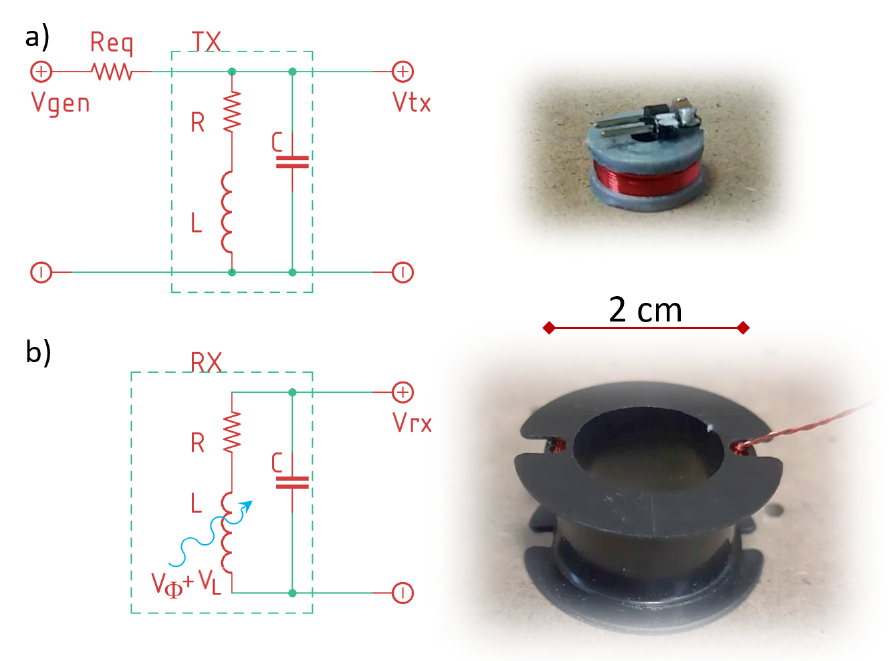
Figure 2. A picture of the TX ( a ) and RX ( b ) solenoids with their circuit model: TX is supplied with voltage V gen from a waveform generator with an equivalent resistance R eq . On the RX solenoid, a voltage V Φ is induced by the external magnetic flux generated by